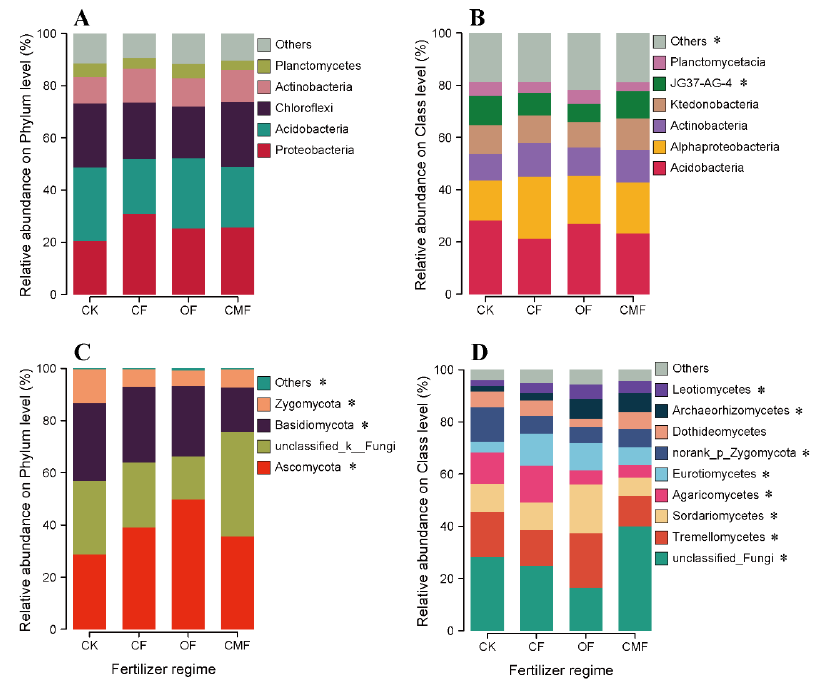
Figure 1. Relative abundances of dominant soil bacterial and fungal phyla ( A , C ) and classes ( B , D ) under four fertilizer regimes. CK, CF, OF, and CMF represent the control, compound fertilizer, organic fertilizer, and compound microbial fertilizer, respectively. Low-abundance phyla/classes with less than 0.5% of the total sequences across all samples are grouped into “Others”. The asterisk indicates the significant differences among different fertilizer regimes.